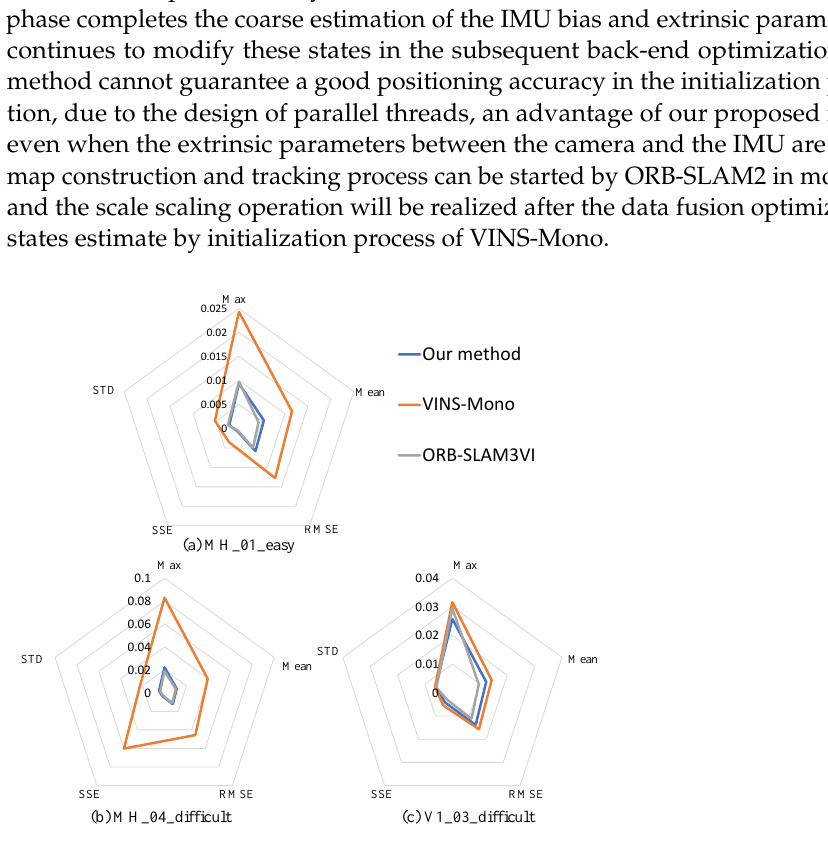
Figure 8. The comparison of trajectories between our method, VINS-Mono, and ORB-SLAM3 with the trajectory truth in absolute trajectory error, respectively.